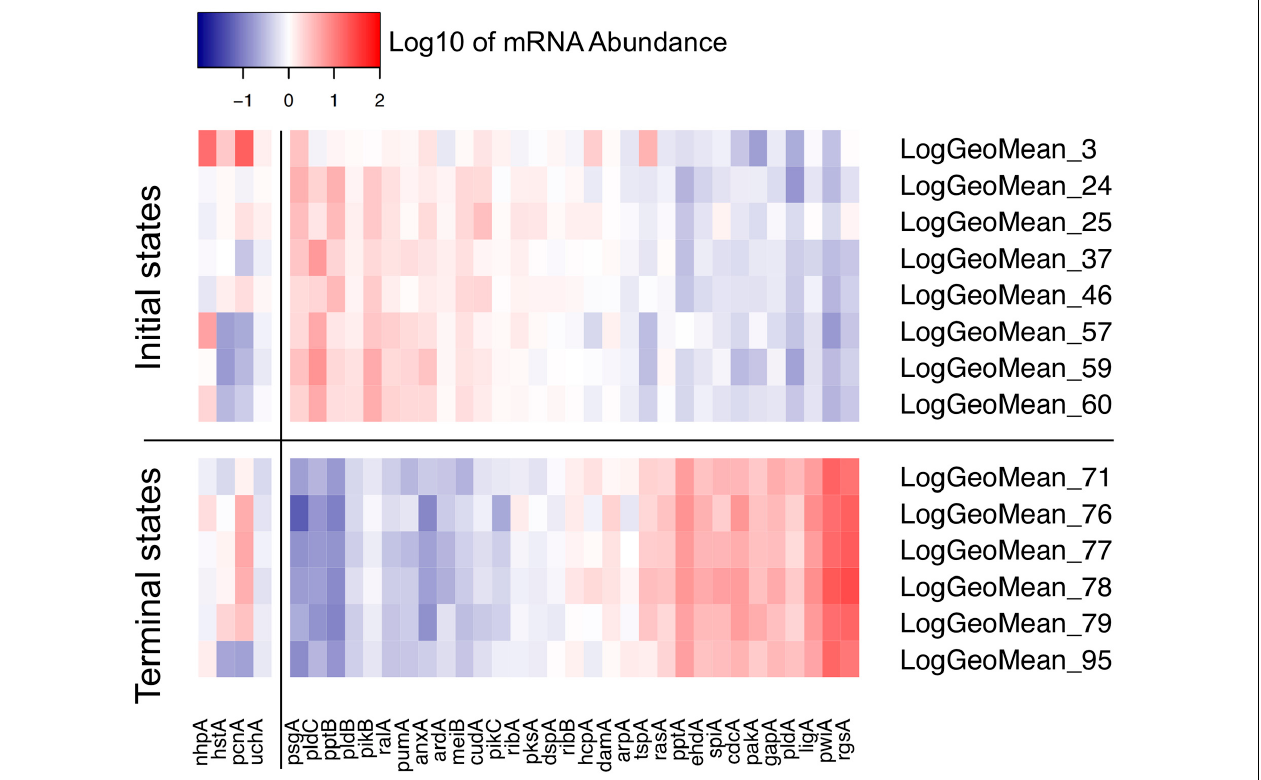
FIGURE 8 | Heat map visualizing the variability of initial and terminal states of gene expression. The initial states displayed in this panel are the start points of trajectories of un-stimulated cells as listed in Table 2 . The terminal states are endpoints of trajectories of far-red stimulated cells corresponding to terminal places of the Petri net of Figure 6 . Color-coded expression values correspond to the logarithm to the base 10 of the geometric mean of all expression values of a respective cluster with its ID number indicated on the right side of the panel. For clarity, expression of the pcnA -group of genes is displayed as a separate